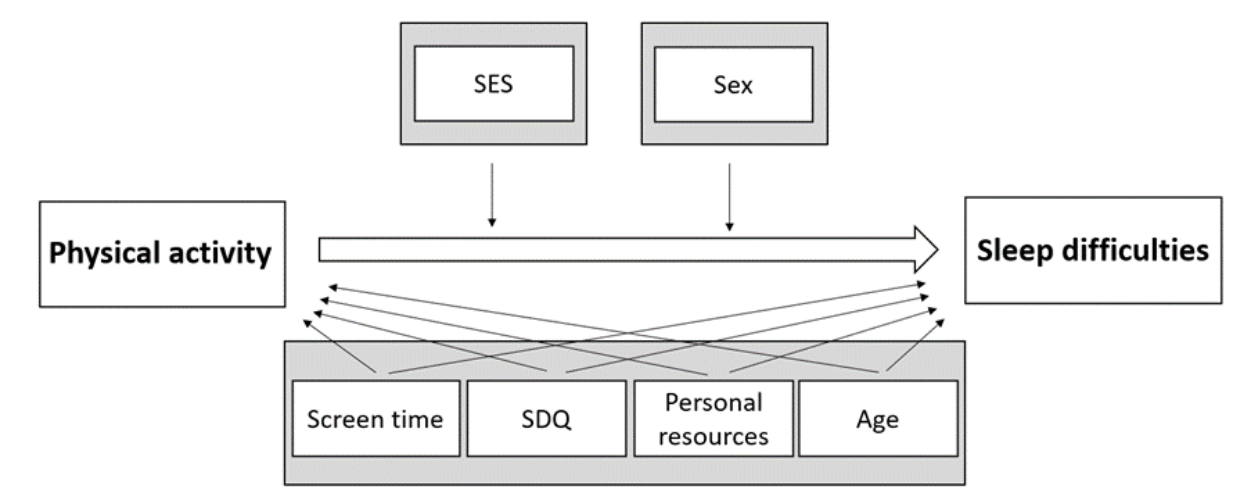
Figure 1. Directed acyclic graph underlying the analyses of the association between physical activity and sleep difficulties. SES, socioeconomic status; SDQ, Strengths and Difficulties Questionnaire.